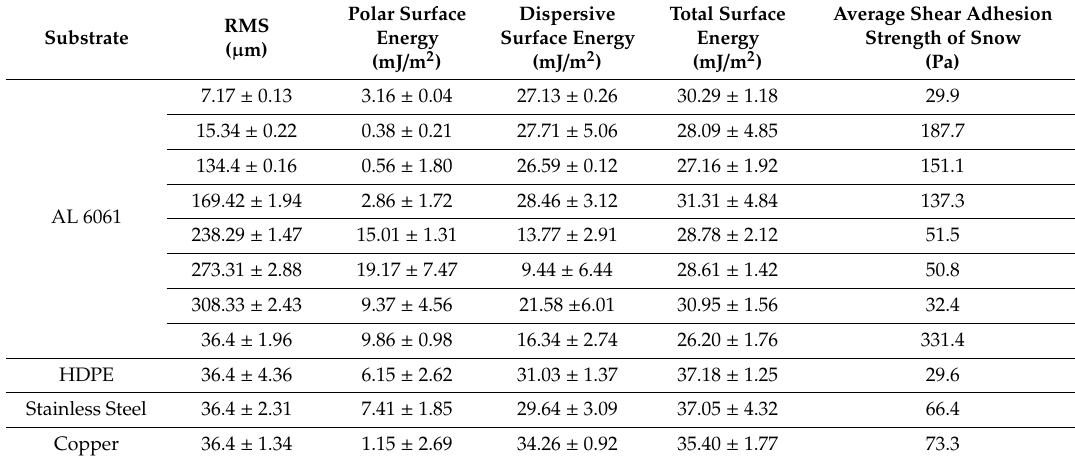
Table 1. Surface energy measurements taken from the Kruss Mobile Surface Analyzer as well as the surface roughness measurements taken from the Keyence VHX 6000 are shown for the substrates that were tested during snow adhesion measurements.